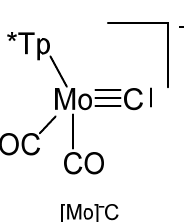
Figure 28. The [Mo] − C core. Tp* = tris(3,5-dimethylpyrazolyl)borate, [HB(pzMe 2 ) 3 ] − or [HB(pz) 3 ] − . Table 16. Compounds with [Mo] − C core with Tp* = [HB(pzMe 2 ) 3 ] − or [HB(pz) 3 ] − 。